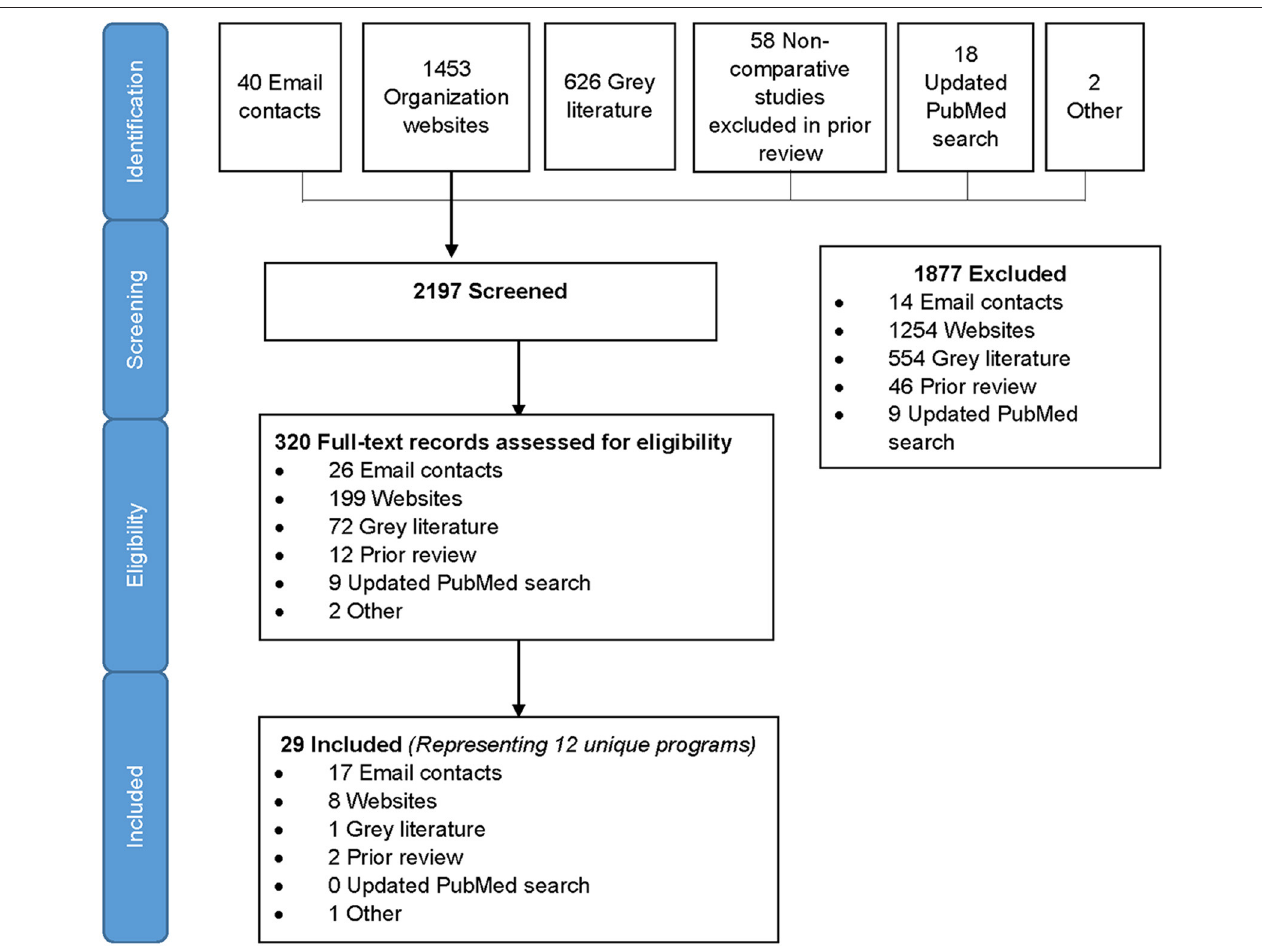
FIGURE 1 | Diagram of record